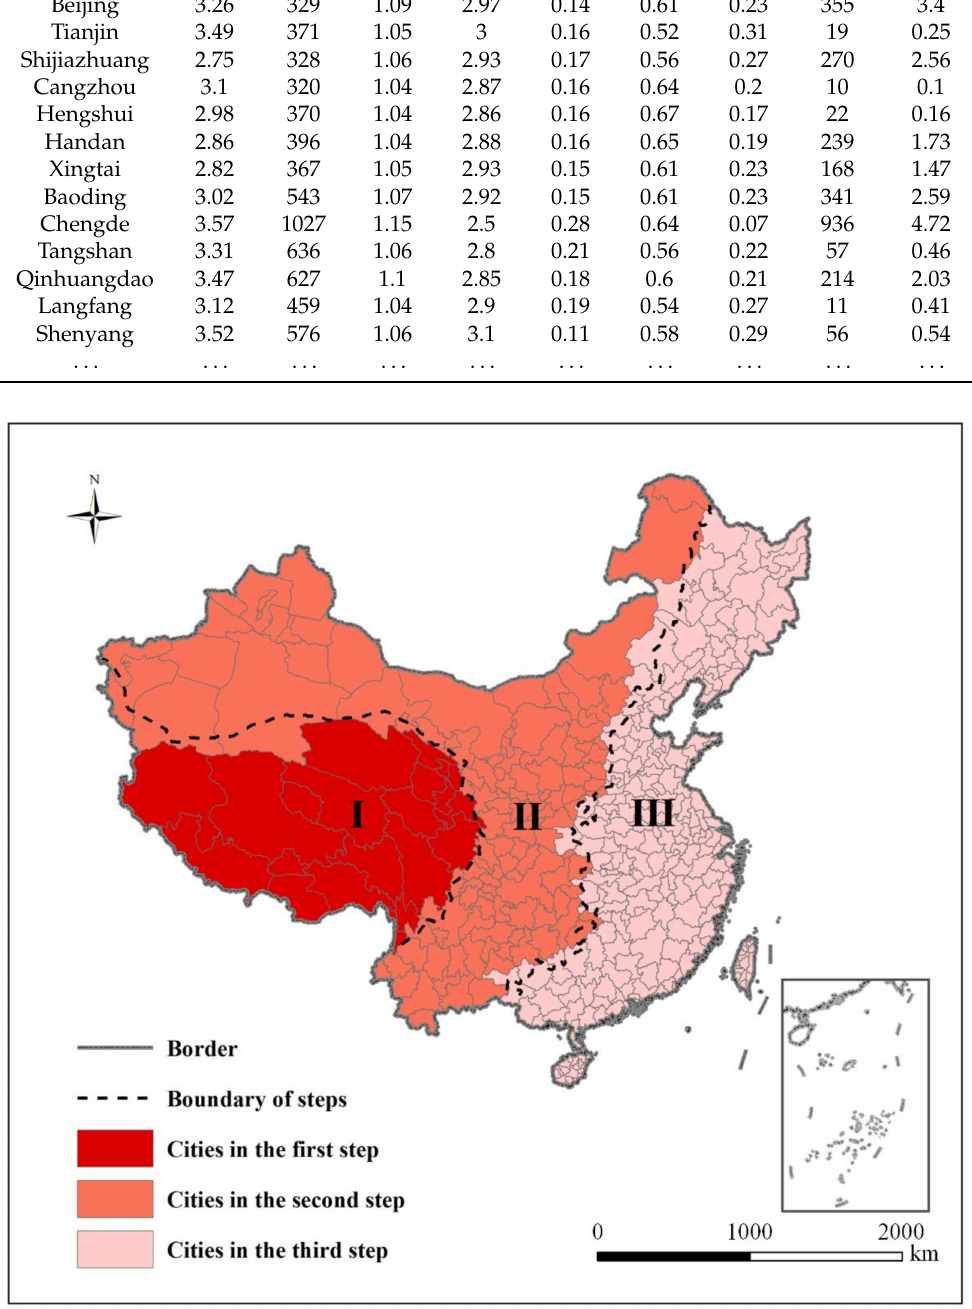
Figure 4. Distribution map based on the three steps of China’s terrain. Table 2 shows the mean, maximum, minimum, and variance of street complexity- related metrics that correspond to the three steps. The mean and variance of topography, orientation entropy, grain, average circuity, and connectedness metrics were standardized by using the Z-score method. The performance of each metric in different steps was compared, as shown in Figure